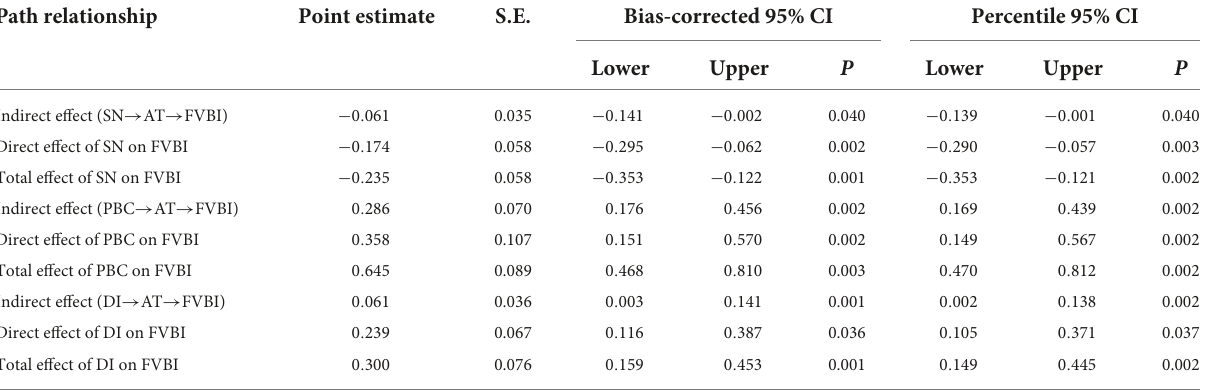
FIGURE2 The final path model.